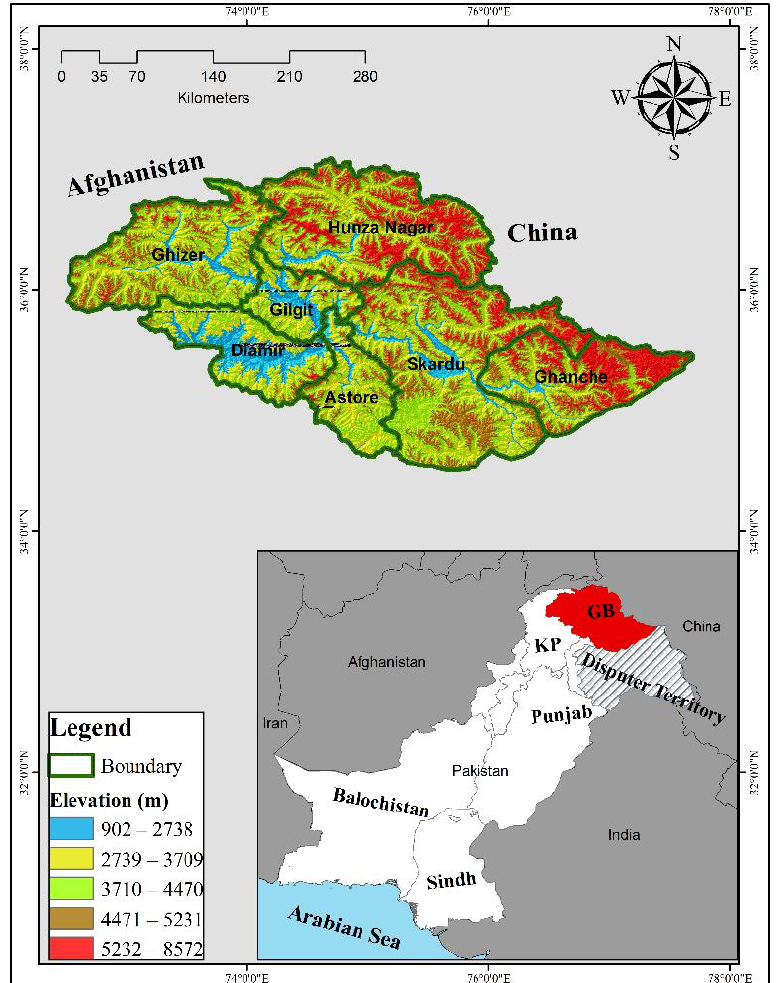
Figure 1. Location map of the Gilgit-Baltistan area. Note: Khyber Pakhtunkhwa (KP).